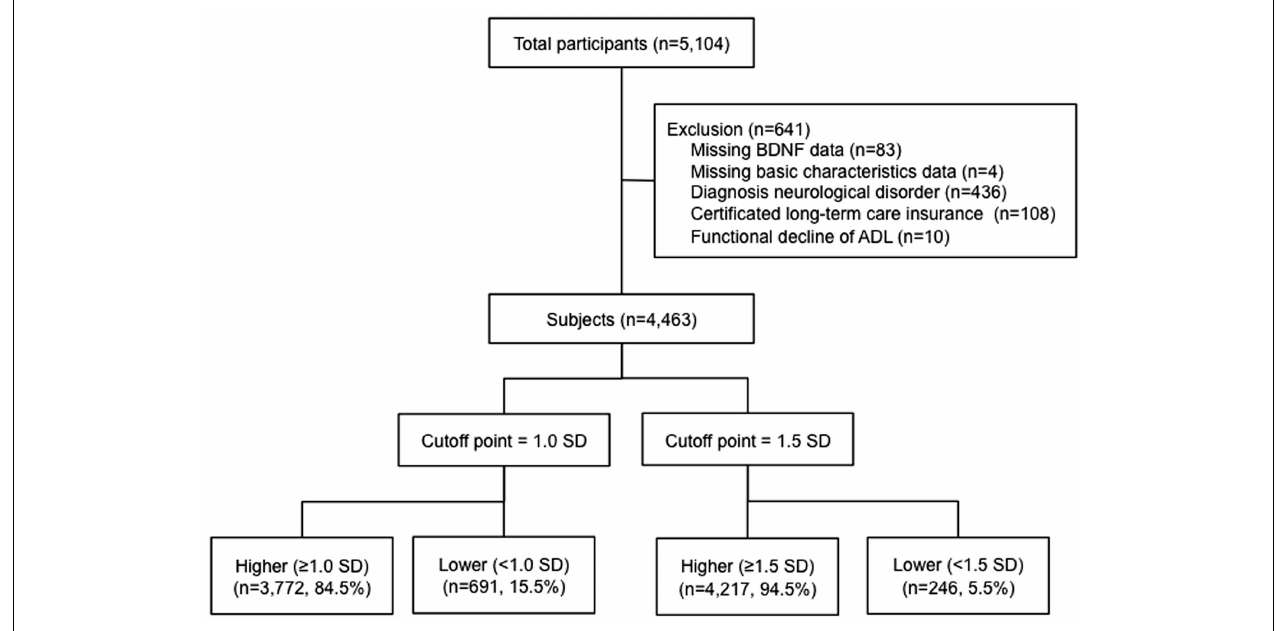
FIGURE 1 | Flow of participants . A total of 4463 participants > 65years of age were included in the study. BDNF levels were measured and the participants were divided into those with higher or lower BDNF levels below 1.0 and 1.5 standard deviations from the mean age- and sex-adjusted BDNF